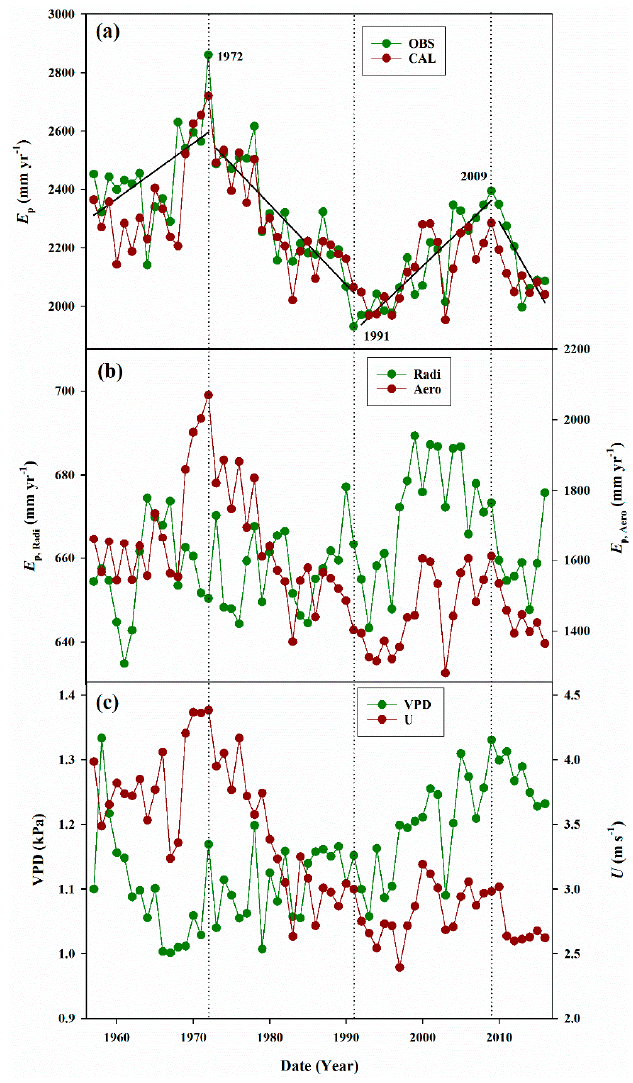
Figure 6. The reconstructed time series of ( a ) the observed pan evaporation ( E p , mm) by the E601 and calculated E p by the modified PenPan model, and ( b ) its two components: radiative ( E p,Radi ) and aerodynamic ( E p,Aero ), and ( c ) associated meteorological variables include the vapor pressure deficit (VPD, kPa) and wind speed ( U , m·s − 1 ) for the Ejin station from 1957 to 2016. The trend line (solid) of the observed E p by the E601 with distinctively different periods is shown in ( a ). The vertical (dotted) lines are the transition period of the observed E p .